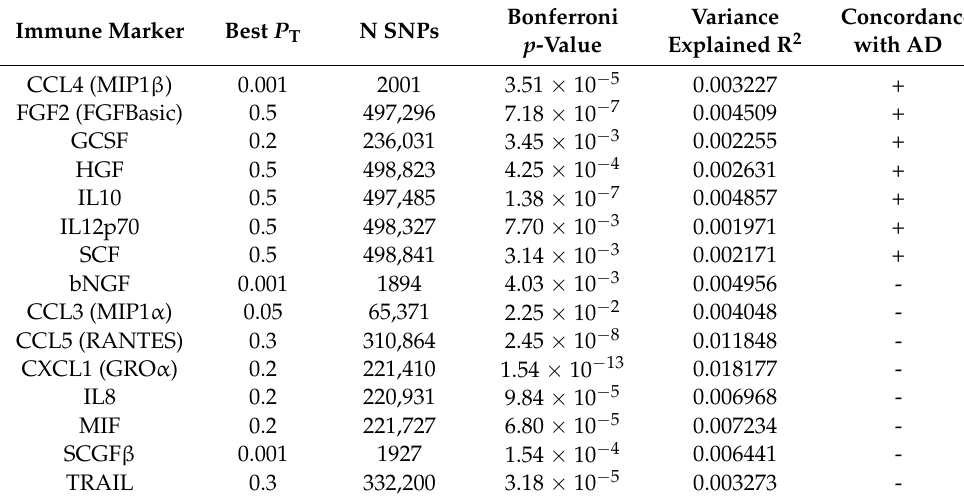
Table 2. Fifteen immune markers for which we identified genetic sharing between AD and their blood